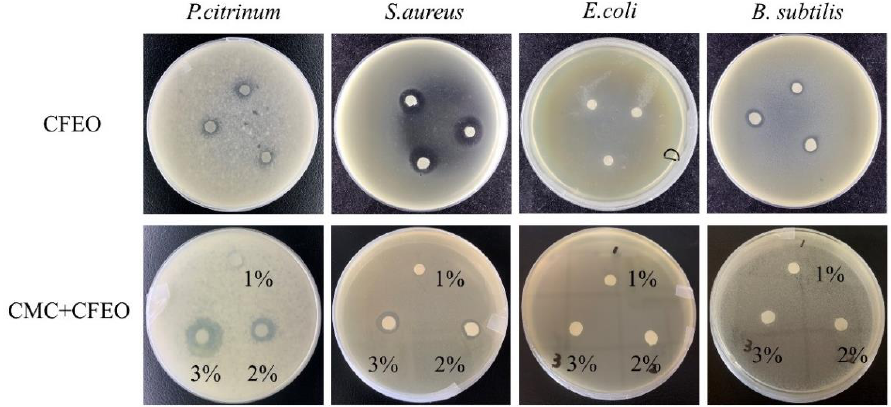
Figure 8. Comparison of inhibition zones in CFEO and composite films. The clear zone around the filter paper is the inhibition